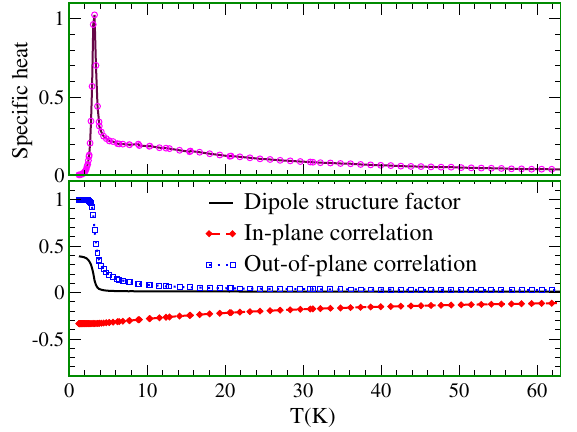
FIG. 3 Thermodynamic properties of the dipoles in BaFe 12 O 19 from the parallel tempering Monte Carlo simulations. The specific heat curve shown in the top panel indicates a long-range order at around 3.0 K. The bottom panel shows the dipole structure factor (i.e., the order parameter O defined in the main text) and local dipole correlations (i.e., in-plane a function of